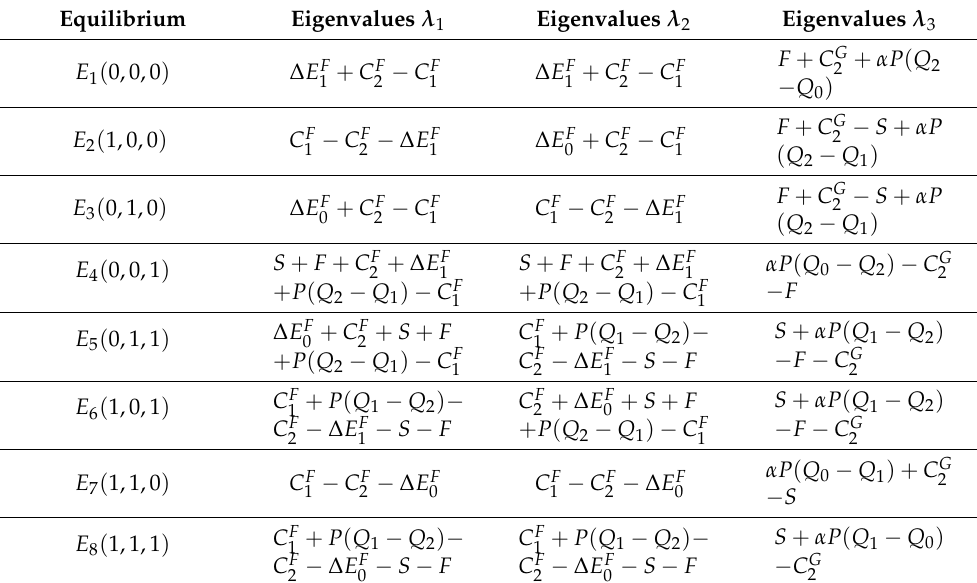
Table 7. The eigenvalues of Jacobian matrix of tripartite evolutionary game.